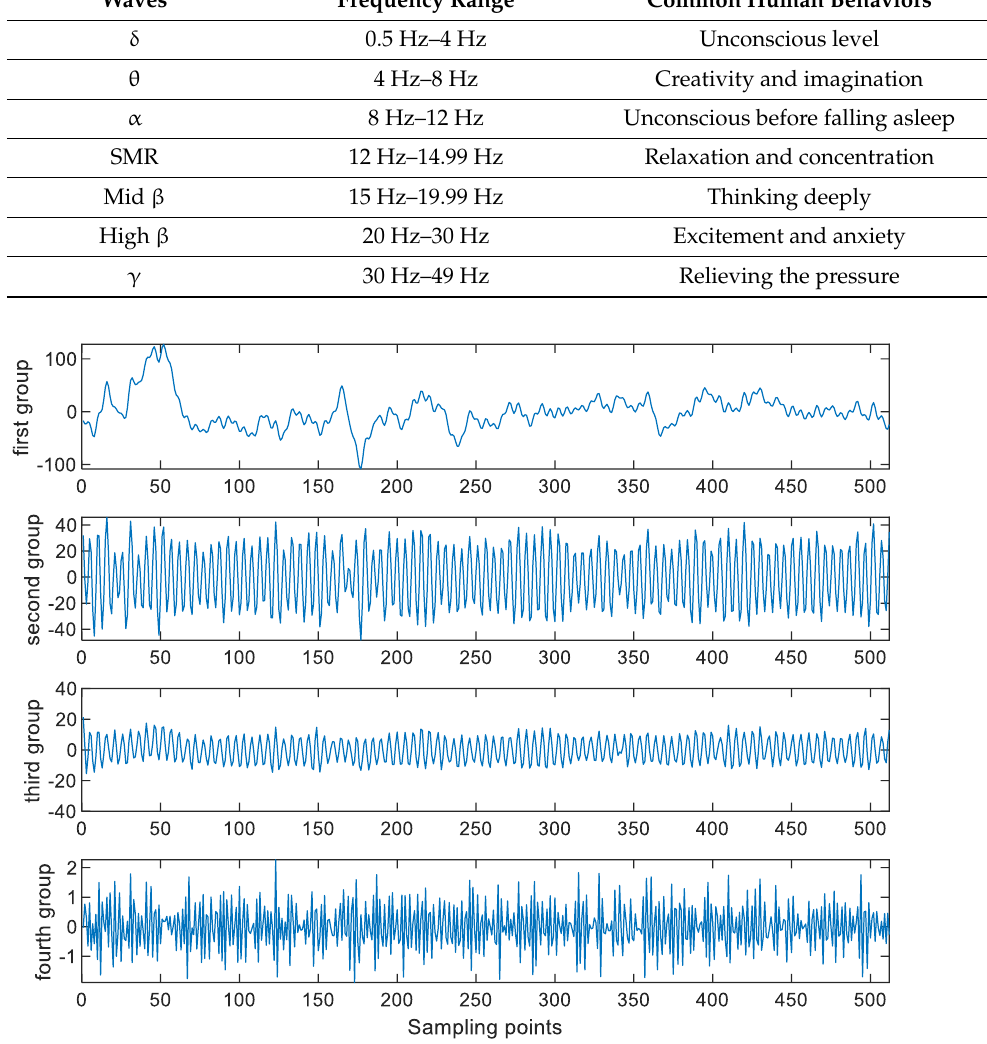
Figure 7. The four groups of the SSA components. Table 3. The common human behaviors and the brain waves responsible for these human behaviors.